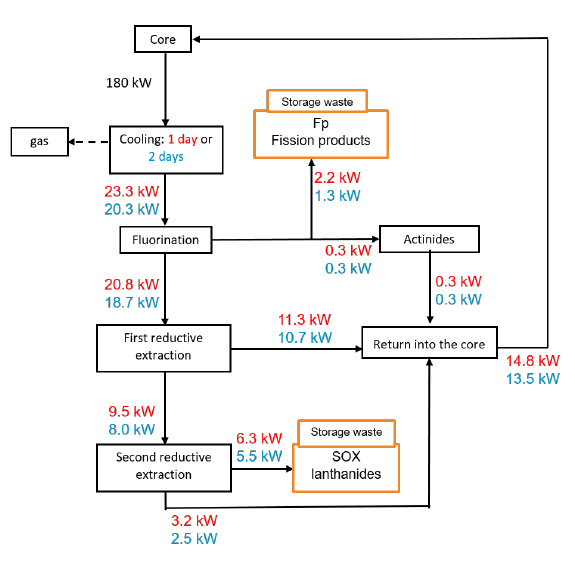
Figure 4. Decay heat evaluation within the chemical